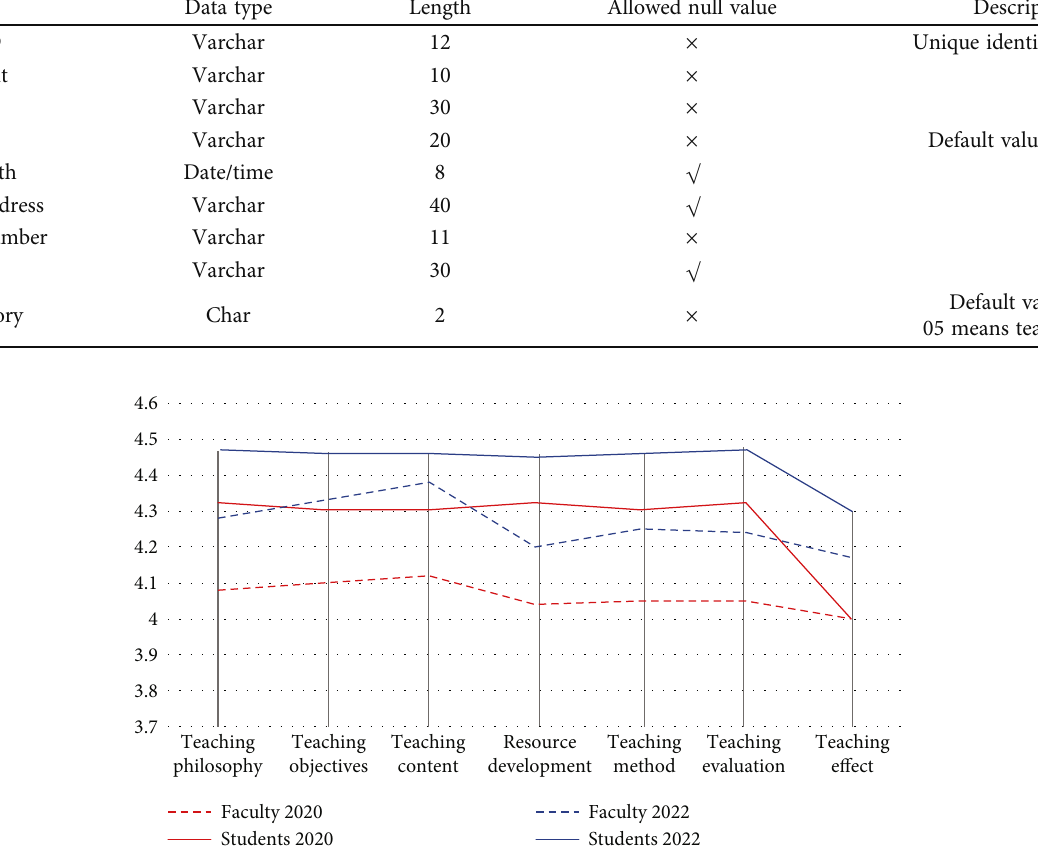
Figure 4: Comparison of online teaching quality evaluation between teachers and